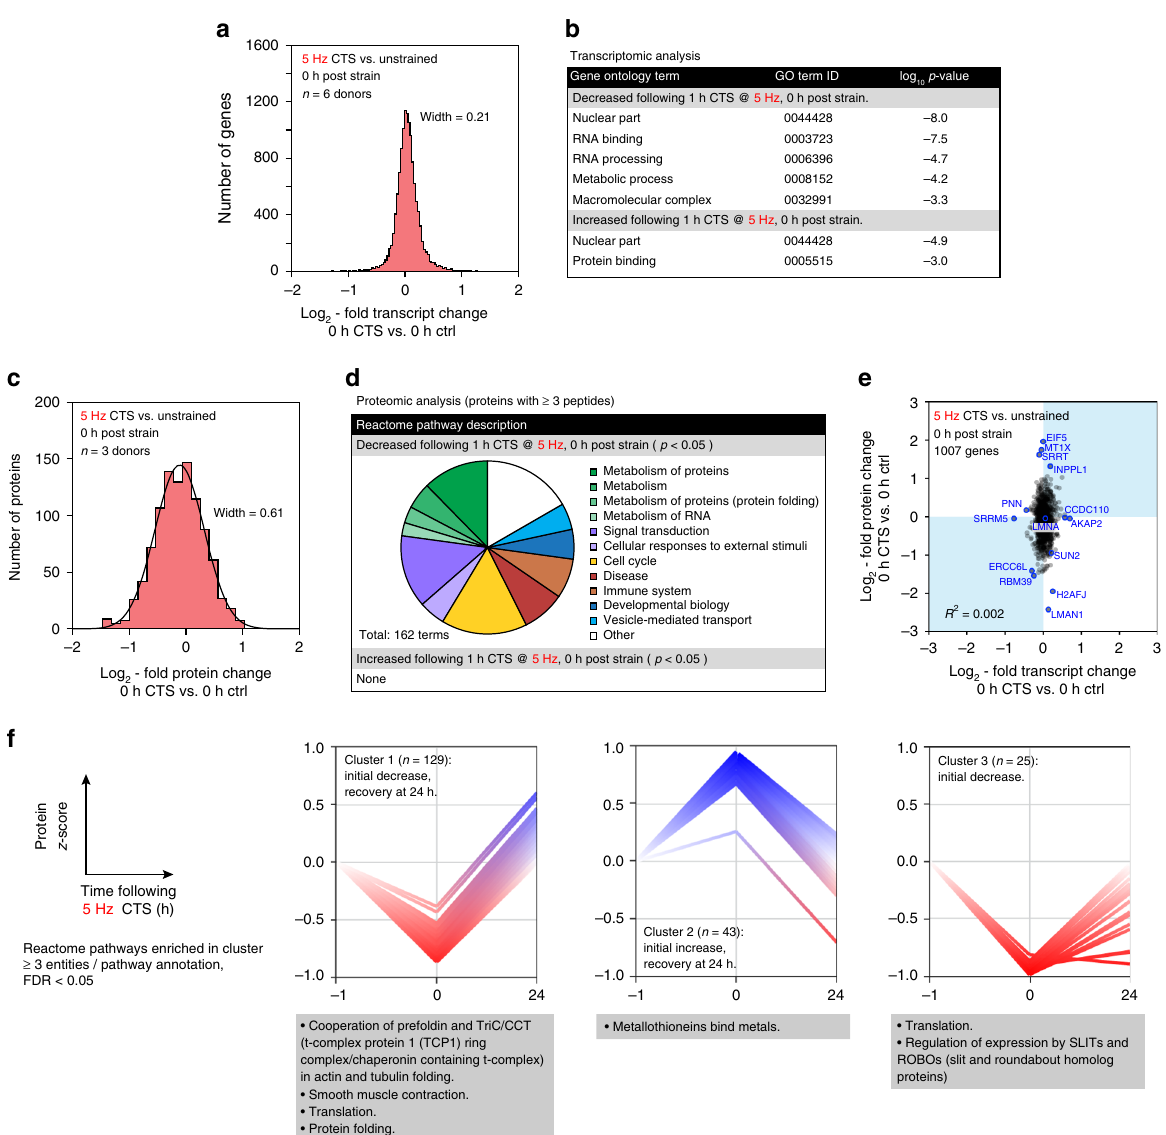
Fig. 2 Changes to the proteome following CTS are uncorrelated to transcript. a Histogram of changes to mRNA in primary hMSCs immediately following high-intensity CTS (1 h at 5 Hz, 2.6 – 6.2 % strain; n = 6 donors); data displayed as log 2 -fold transcript change CTS versus unstrained controls. The width of a Gaussian curve fi tted to the distribution was 0.21. There were no signi fi cant changes in SUN2 . See Supplementary Data 1 and 2. b Gene ontology (GO) term analysis of the transcripts signi fi cantly affected by CTS. Annotations suggest nuclear remodeling (nuclear component terms are both up- and down- regulated), and down-regulation of RNA processing and metabolism. c Histogram of proteomic changes quanti fi ed by mass spectrometry (MS) immediately following CTS (1 h at 5 Hz, 2.6 – 6.2 % strain; n = 3 donors). Data displayed as log 2 -fold change following CTS, versus unstrained controls. Proteins quanti fi ed by ≥ 3 peptides. See Supplementary Fig. 4b for volcano plot and Supplementary Data 3 and 4. A Gaussian curve fi t to the distribution had a width of 0.61 and maximum at − 0.11 ± 0.01. d Analysis of Reactome pathways signi fi cantly affected at the protein level following CTS ( p < 0.05; proteins quanti fi ed by ≥ 3 peptides; n = 3 donors). Proteins associated with cellular metabolic processes were decreased following strain, including protein and RNA associated metabolism. e Correlation plot between proteome and transcriptome immediately following CTS (1007 genes quanti fi ed by RNA-seq and in proteomics by ≥ 3 peptides; selected outlying genes/proteins of interest are annotated; R-squared = 0.002). The distribution of changes to protein levels was broader than, and uncorrelated with, transcript changes. Transcript and protein levels were partially recovered 24 h after CTS (Supplementary Fig. 4a, c – e). f K-means clustering was used to group quanti fi ed proteins based on their response to CTS after 0 and 24 h. Analysis showed four possible clusters to be most appropriate for this dataset (Supplementary Fig. 4f). Three clusters are shown annotated with signi fi cant Reactome enrichments; ≥